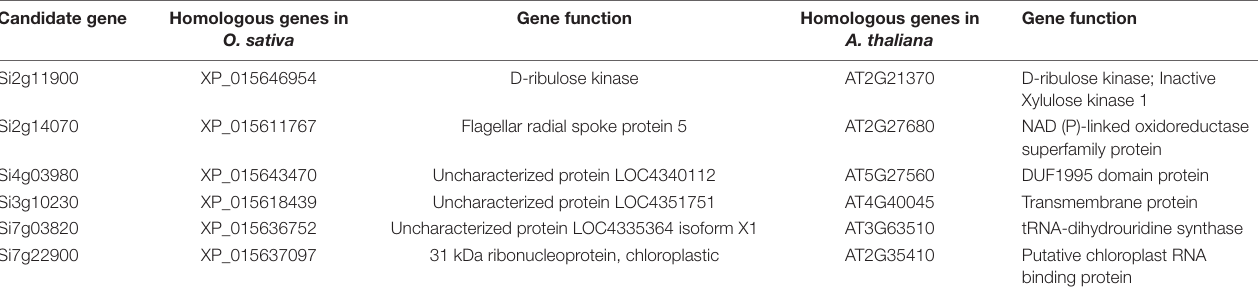
TABLE 1 | Functional annotation of modular hub genes. Candidate gene Homologous genes in O. sativa